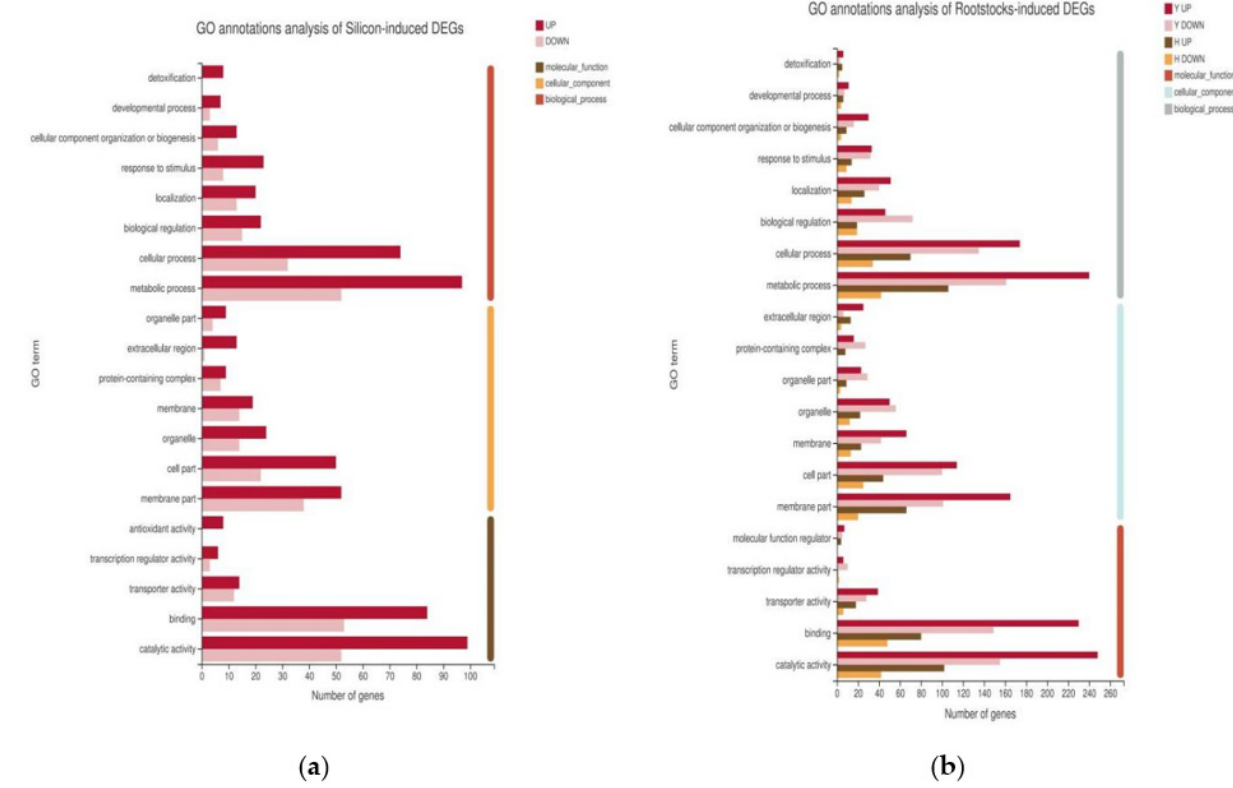
Figure 3. GO annotation analysis of DEGs for ( a ) the comparison of self-rooted cucumber with silicon addition (Z+) and self-rooted cucumber (Z), and ( b ) the comparison of two types of rootstock-grafted Cucumber (H and Y) with self-rooted cucumber (Z).